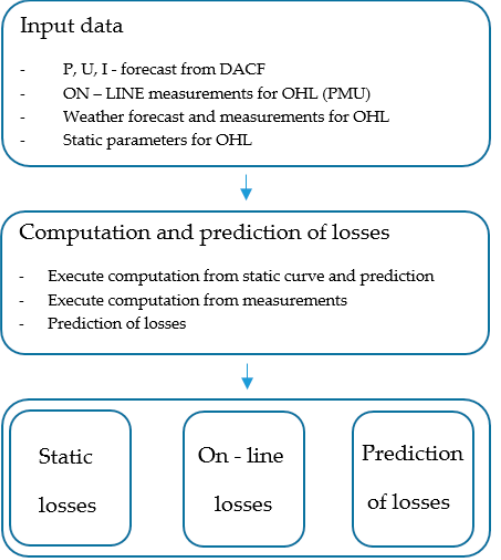
Figure 9. Flow chart of the model for calculating on-line and prediction of